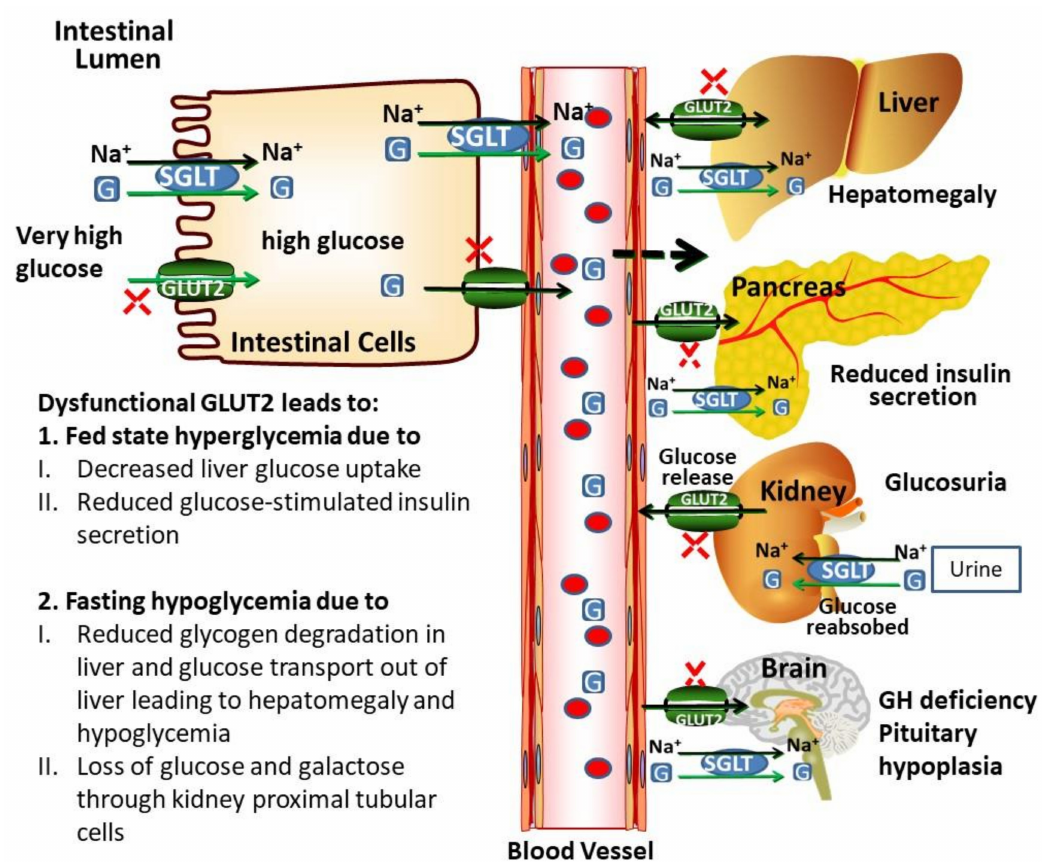
Figure 4. GLUT2-mediated glucose transport across cell membranes and communication to di ff erent organs. GLUT2 is a low a ffi nity and high capacity glucose transporter and facilitates the transport of glucose in intestinal cells. SGLTs are high-a ffi nity and low capacity transporters, capable of transporting glucose against a concentration gradient. Ghrelin increases the GLUT2 expression by modulating the GLUT2 transcription via GHS-R1 (growth hormone secretagogue receptor 1a) and PLC / PKC pathway. Ghrelin also stimulates translocation of GLUT2 to the surfaces of intestinal cell from intracellular vesicles, leading to increased glucose absorption. GLUT2 is highly expressed in the liver, pancreas, brain and kidney cells. Activation of nervous signals, induces the first phase of insulin release from pancreatic β -cells induced by increased glucose transport to pancreatic β -cells. These signals also induce other physiological processes. In the liver, GLUT2 maintains the glucose homeostasis during fasting and fed state by regulating the expression of glucose-sensitive genes. GLUT2 is more highly expressed in rodent β -cells than in human β -cells. In the brain, glucose-sensing cells expressing GLUT2, regulate glucose by parasympathetic and sympathetic systems. GLUT2-dependent glucose-sensing cells also regulate leptin sensitivity and regulate the expressions of uncoupling protein 1 (UCP1) and thermogenesis. Homozygous GLUT2 mutation leads to a dysfunctional and reduced expression of GLUT2, which causes FBS. Dysfunctional GLUT2 causes fasting hypoglycemia, postprandial hyperglycemia, glucose and galactose intolerance, hepatomegaly, glucosuria, reduced GSIS (glucose-stimulated insulin secretion), rickets, GH (growth hormone) deficiency and poor, growth. (G;